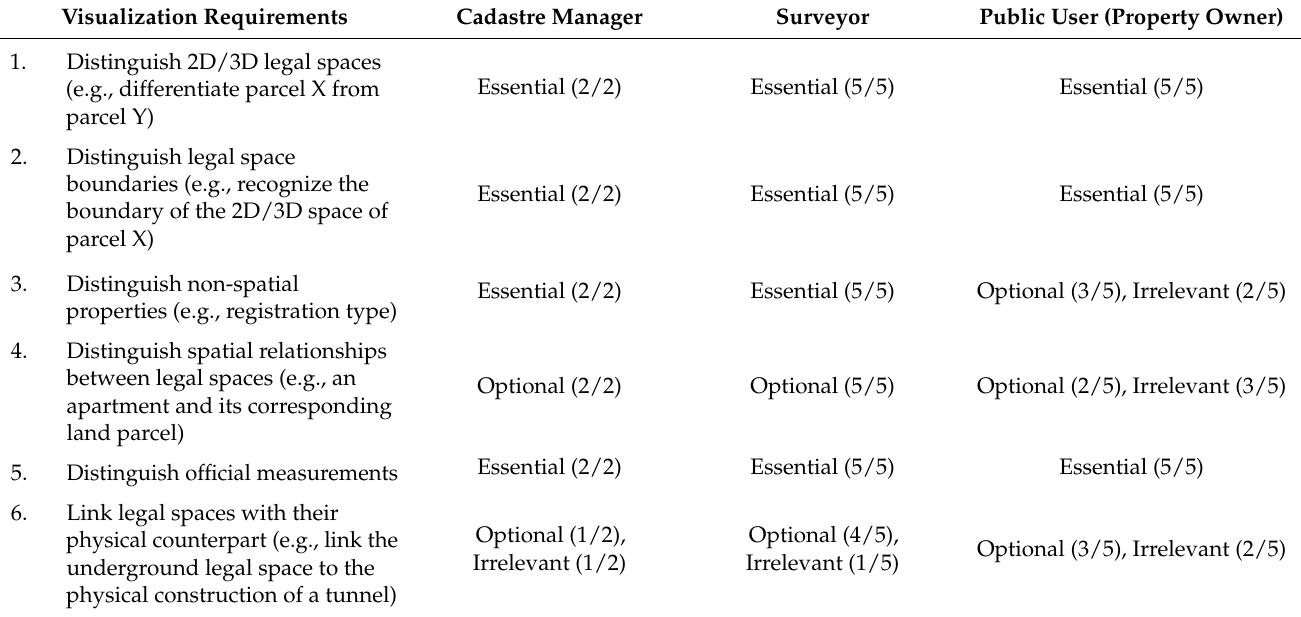
Table 1. The interviewees’ responses to the 3D cadastre visualization